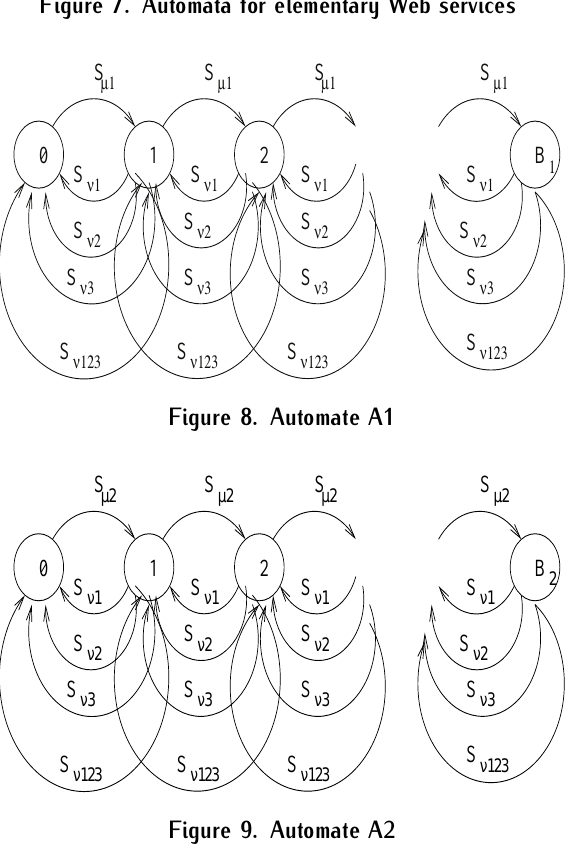
Figure 7. Automata for elementary Web services